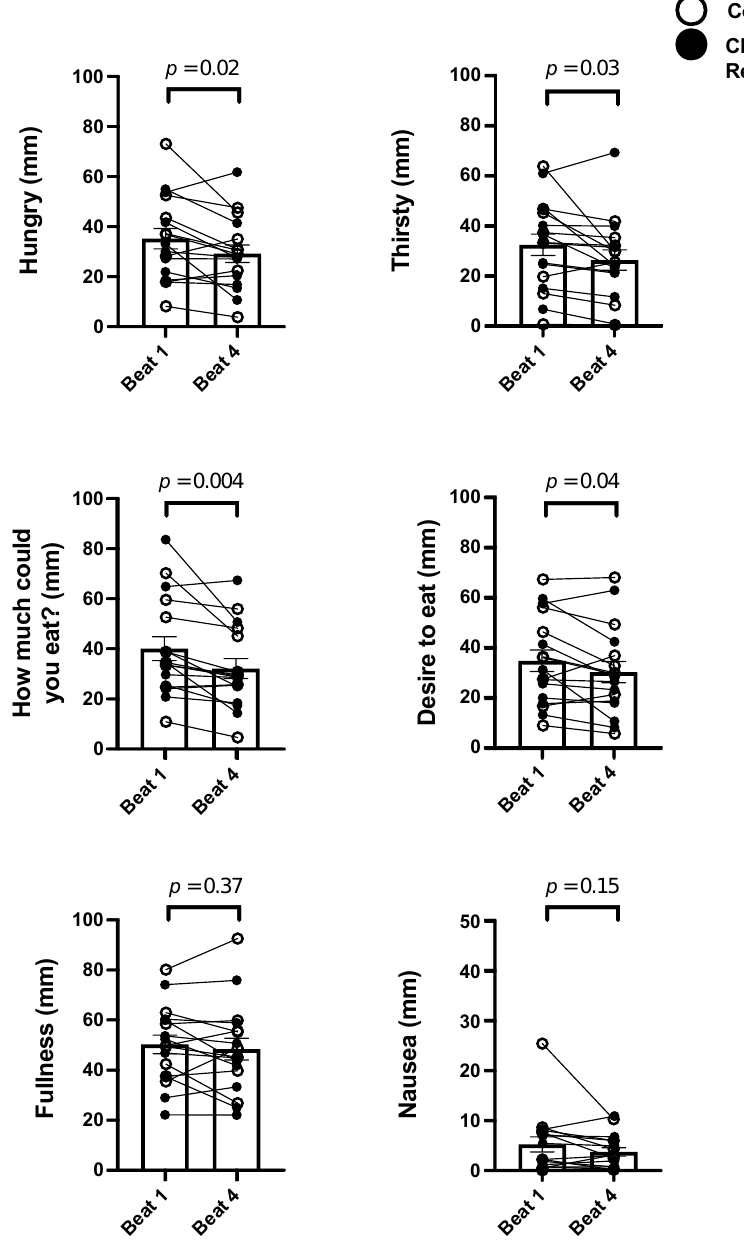
Figure 2. Chronic impact of circadian disruption on subjective hunger and appetite. Data from the Control ( n = 8, 1:2 sleep:wake ratio) participants are denoted by open circles and those from the Chronic Sleep Restriction (CSR, n = 9, 1:3.3 sleep:wake ratio) participants are denoted by closed circles. Higher scores indicate higher subjective feelings of each aspect of hunger and appetite. Beat cycles (i.e., time to complete a cycle of circadian and sleep:wake schedule combinations, which was ~6 protocol days in this forced desynchrony design) of the protocol are shown on the x -axis. Group means are each beat cycle are denoted by the open column and error bars represent SEM. Note, the y -axis of Nausea is approximately one-half the range of the others. p values are derived from independent t -tests used to test differences between Beat cycle 1 and Beat cycle 4.